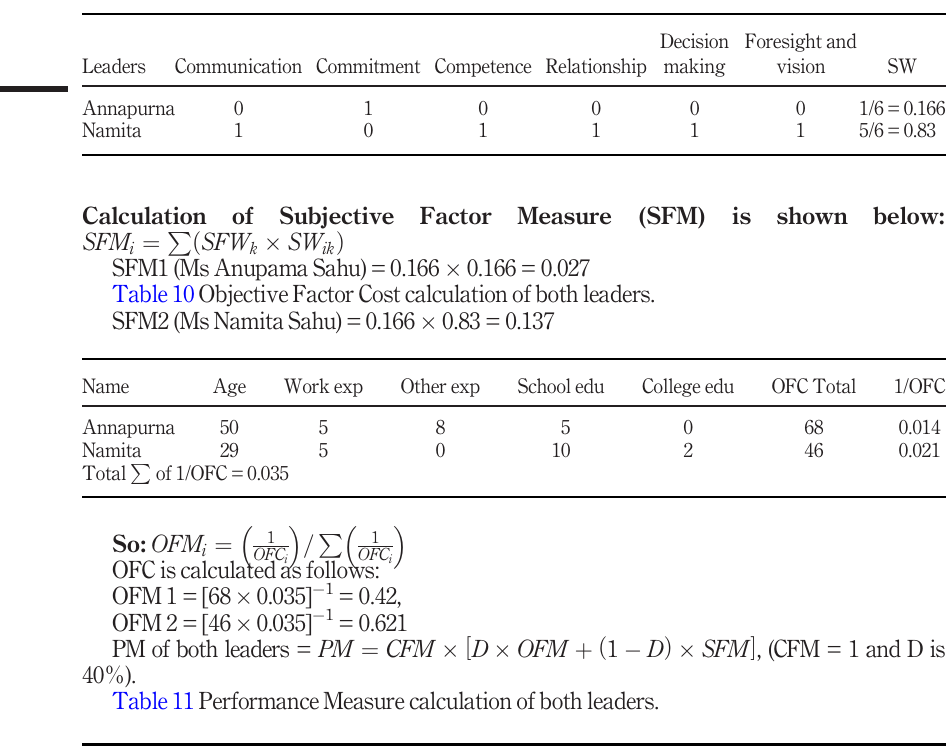
Table 9 Subjective Weightages of both the leaders (Comparison of parameters and leaders).